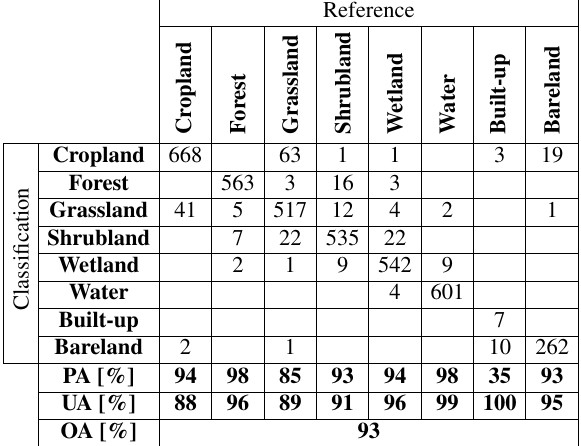
Table 4: Error matrix and accuracy indexes for land cover for